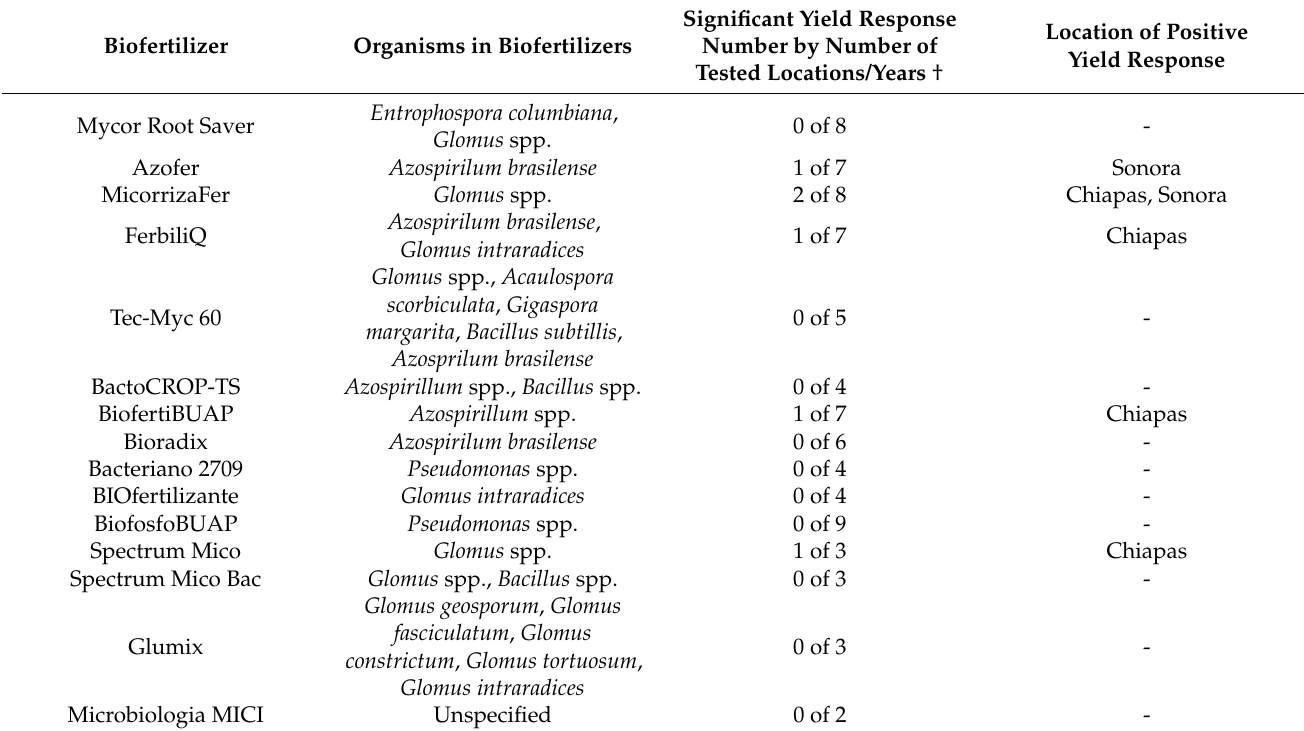
Table 11. Number of significant biofertilizers yield responses by number of experiments tested across locations, cycles, and